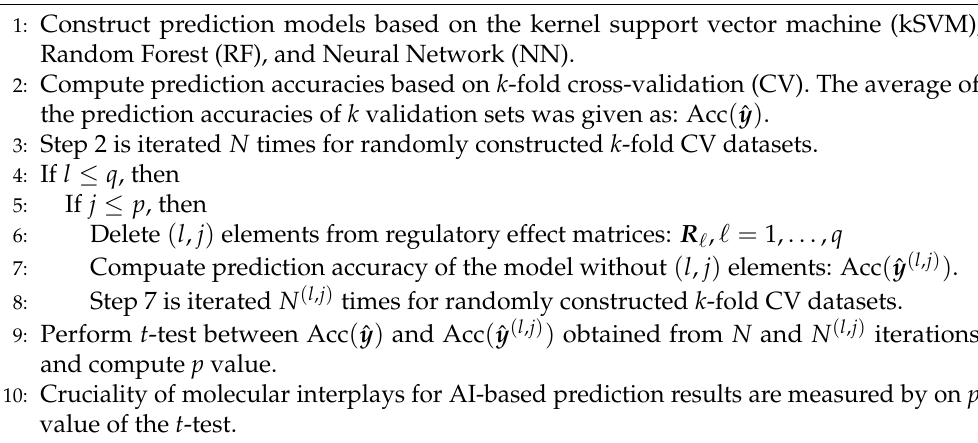
Algorithm 2 Xprediction: explainable